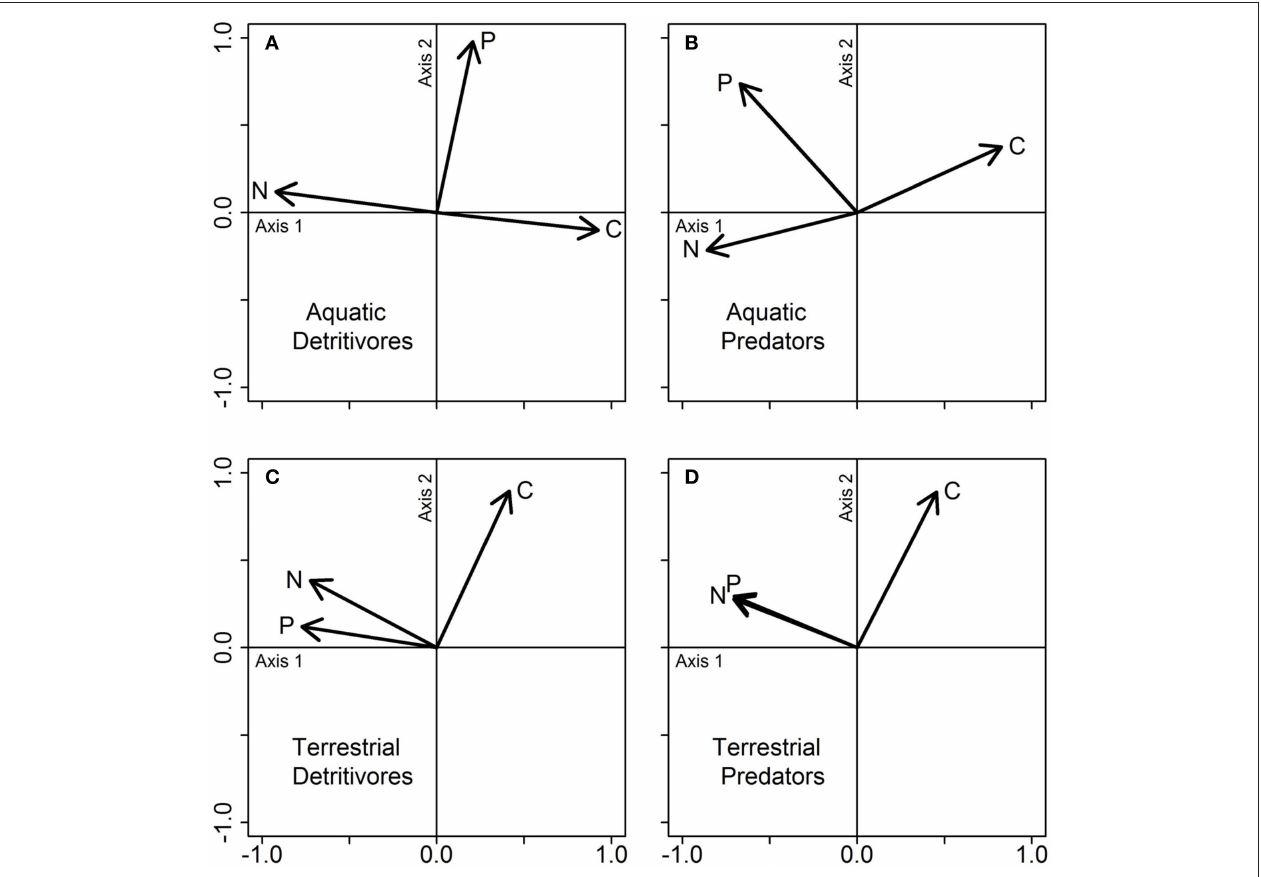
FIGURE 8 | PCA on the stoichiometric traits of aquatic (A,B) and terrestrial (C,D) detritivores, and predators. Note that terrestrial herbivores are displayed in Figure 6 . Each plot represents a PCA conducted separately for each group of organisms, using the data displayed jointly in Figure 7 . Vectors show the influence of the three stoichiometric traits (C, N, and P contents) on each PCA